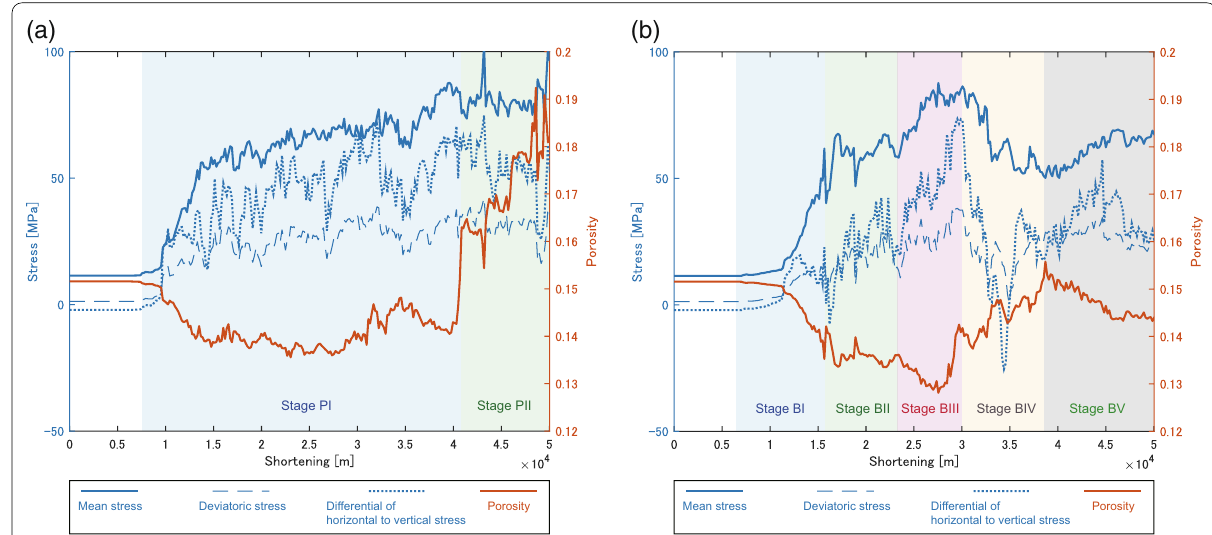
Fig. 5 The stress state (mean stress, deviatoric stress, and differential of the horizontal to vertical stress) and porosity around the monitoring particles. a The reference model without BTHs (Fig. 2) and b the model for multiple BTH collisions (Fig.